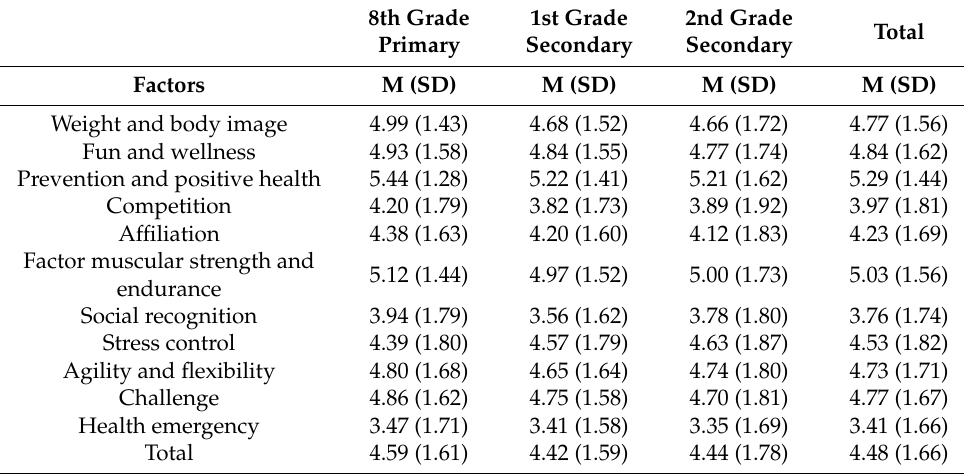
Table 4. Descriptive results of the AMPEF factors, by grade.